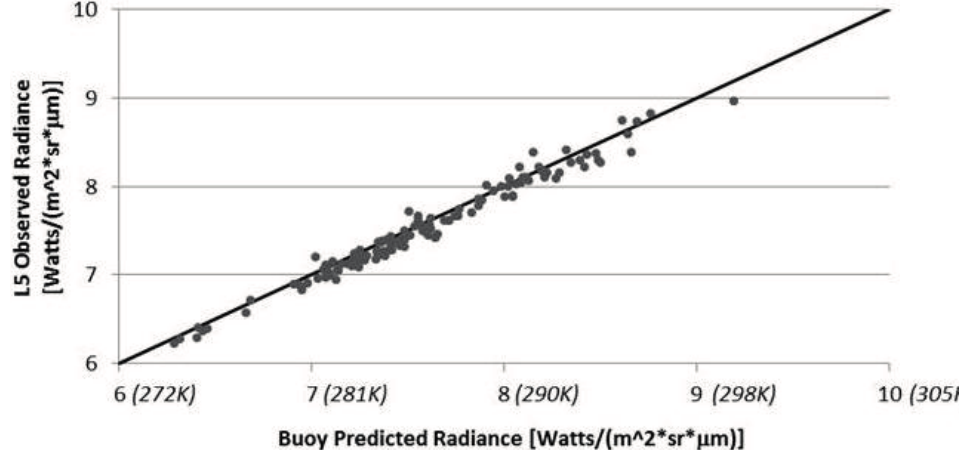
Figure 6. Plot of top of atmosphere (ToA) buoy predicted radiance (apparent temperature) vs. satellite observed radiance for Landsat 5 after removal of six cloud contaminated points (mean error − 0.52 K ± 0.72